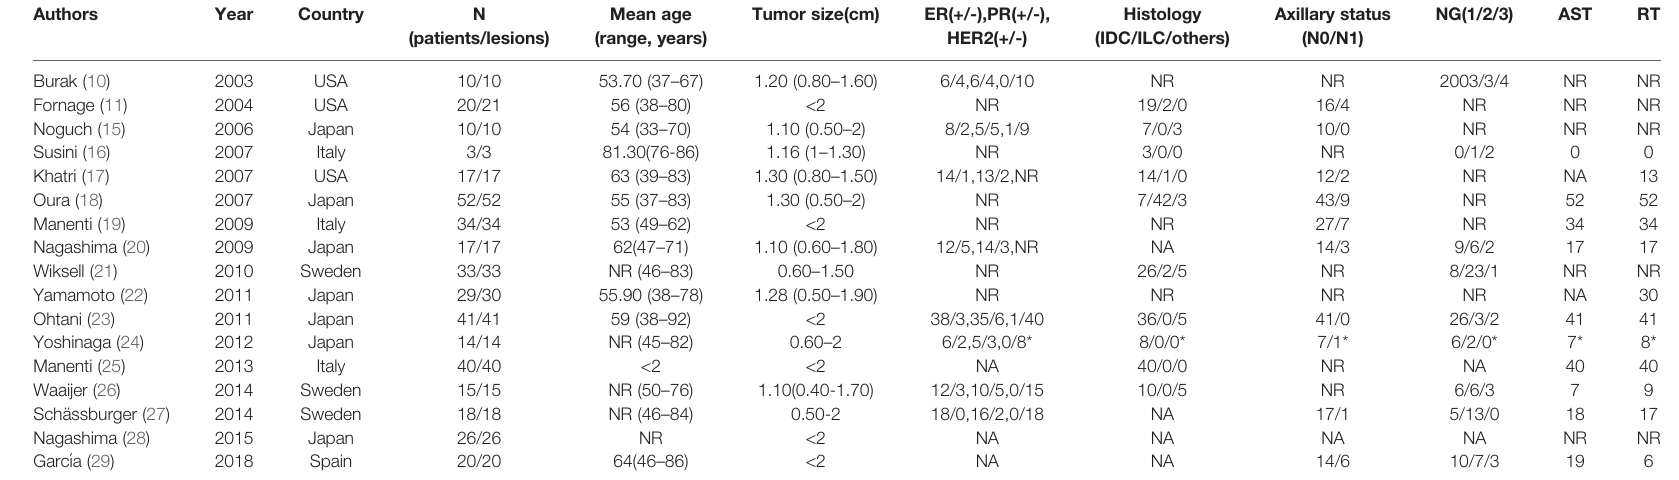
TABLE 1 | Patient and tumor characteristics in the trials included in the meta-analysis. Authors